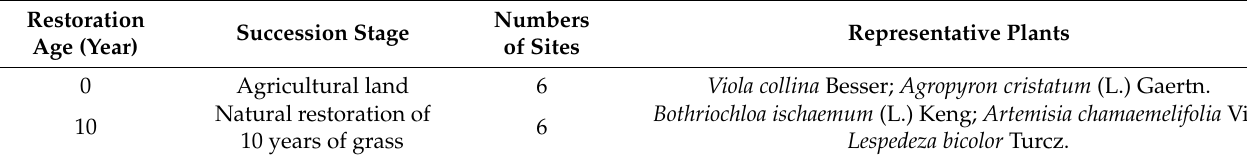
Table 1. Vegetation survey sample site information at the Ziwuling study area on the Chinese Loess